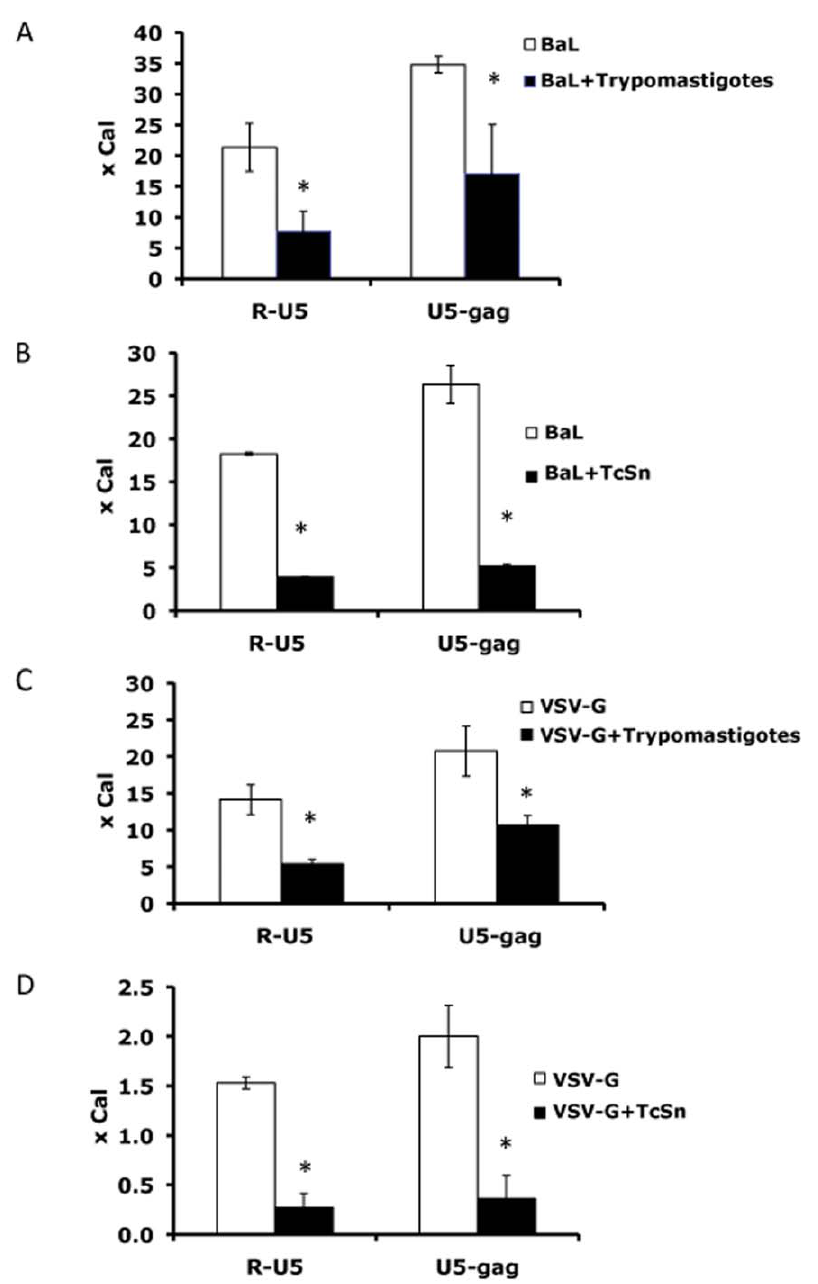
Figure 6. Inhibition of HIV entry and reverse transcription by T.cruzi . MDM were infected with BaL pseudotyped virus in the presence of ( A ) trypomastigotes or ( B ) TcSn or VSV-G pseudotyped virus in the presence of ( C ) trypomastigotes or ( D ) TcSn, overnight. Single viral infections with both pseudotypes were performed as control. DNA was isolated and early (R-U5) and late (U5- gag ) transcripts were quantified by real-time PCR 24 h p.i. Results are expressed as an n-fold difference with respect to the calibrator (x Cal) 6 SD of infection duplicates. Results are representative of 3 independent experiments performed with cells from different donors. * p , 0.05.